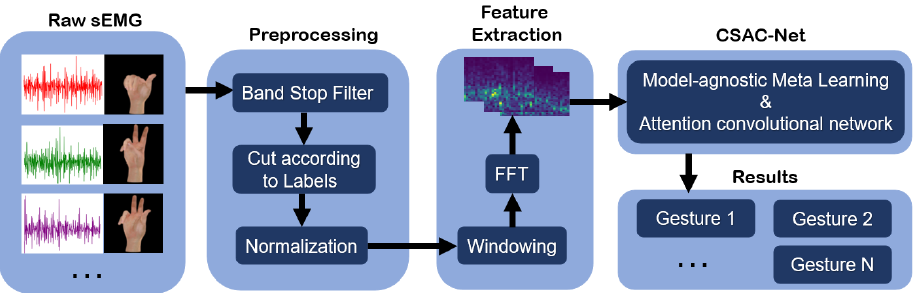
Figure 1. An overview of the method in a block diagram